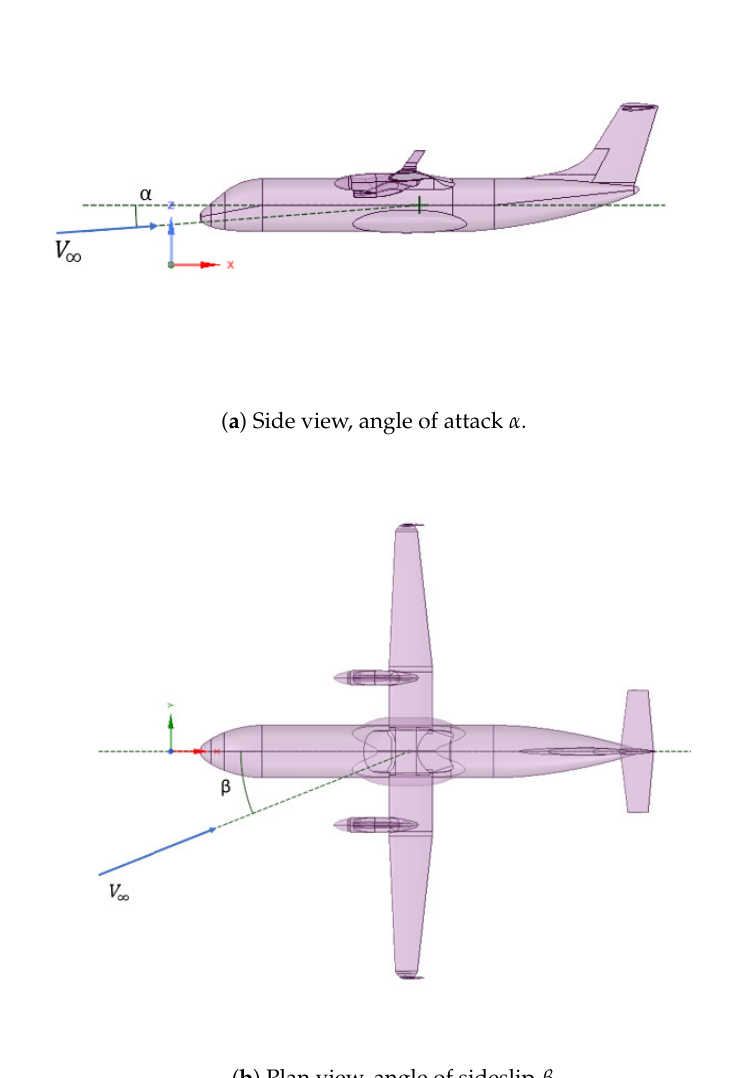
Figure 1. Aircraft side and plan views, angles of attack, and